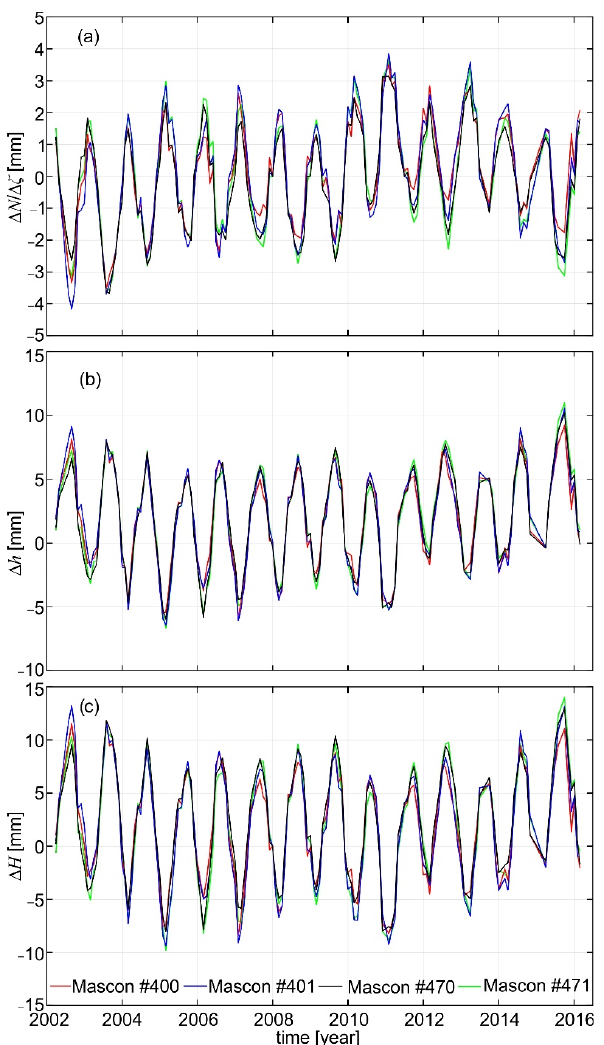
Figure 6. Time series of ( a ) geoid/quasigeoid changes ( Δ N / Δ ζ ), ( b ) vertical deformations of the Earth’s surface ( Δ h ), and ( c ) temporal variations of orthometric/normal heights ( Δ H / Δ H * ) over Poland estimated using GRACE ‐ based GGMs.